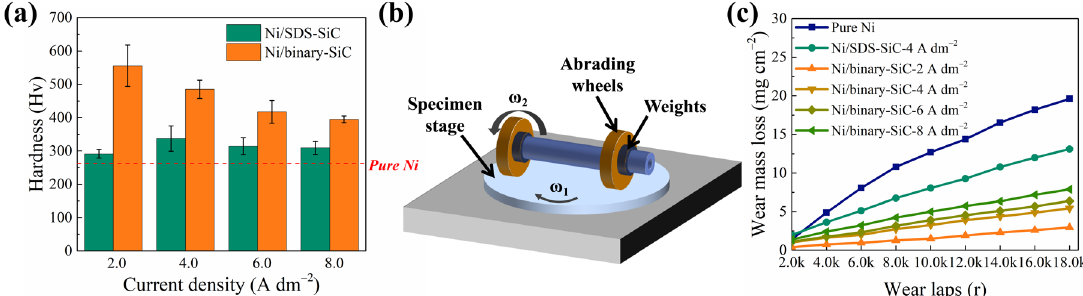
Figure 6. ( a ) Microhardness of the Ni/SDS - SiC and Ni/binary - SiC coatings, ( b ) schematic illustrating the abrasive resistance test, and ( c ) wear loss weight curves of the Ni/SDS - SiC and Ni/binary - SiC coatings.